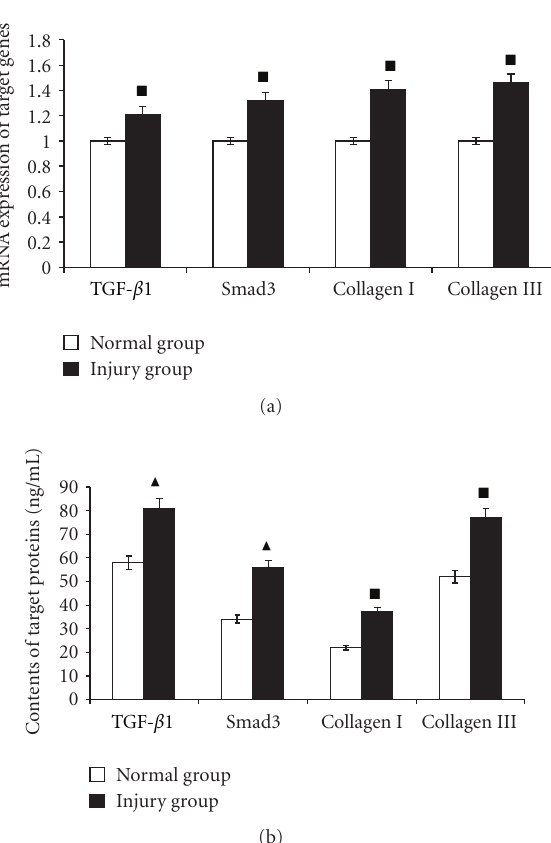
Figure 1: Expressions of TGF- β , Smad3, and type I and III collagen in VSMCs from rats undergoing carotid artery balloon injury.